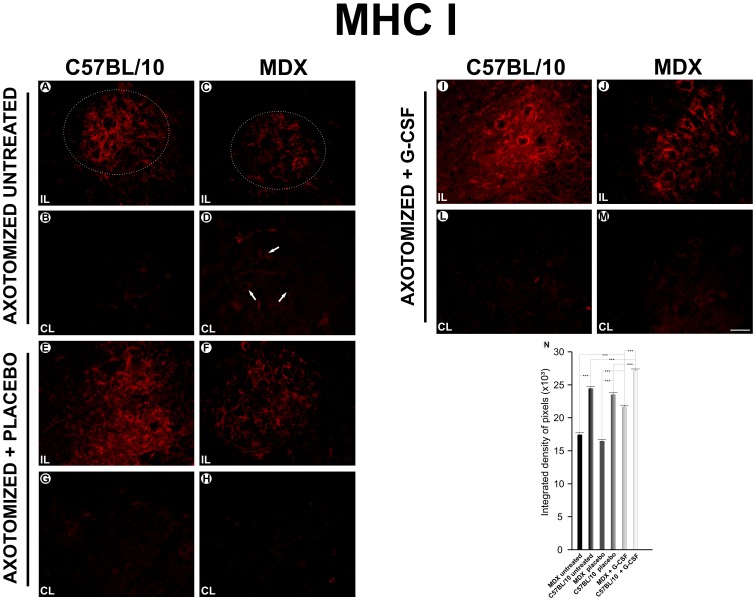
Anti-MHC I immunostaining one week after axotomy.
A and C, the ipsilateral (IL) and contralateral ventral column of the spinal cord of the C57BL/10 strain seven days after axotomy; B and D, the ipsilateral and contralateral ventral column of the spinal cord of the MDX strain seven days after axotomy; E and G, the ipsilateral and contralateral of the C57BL/10 ipsilateral+ placebo group seven days after the axotomy; F and H, the ipsilateral and contralateral of the MDX ipsilateral+ placebo group; I and L, the ipsilateral and contralateral of the C57BL/10 ipsilateral+ G-CCSF group; J and M, the ipsilateral and contralateral of the MDX ipsilateral+ G-CSF group. (N) the quantitative analysis of the integrated density of the pixels between the left sides of the groups studied. In all experiments: n = 5. In A–M, magnification, X200 (scale bar, 50 µm). The alpha-motoneurons were quantified in 3 distinct fields along the lumbar intumescence. In N, ***p<0.001 vs. CT, values are means ± SEM.